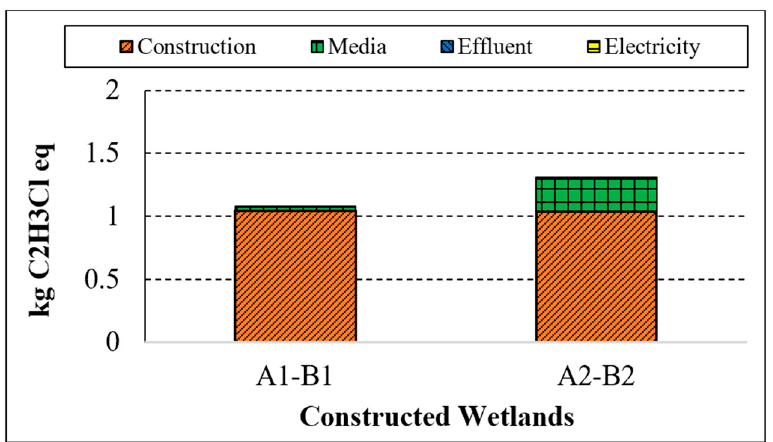
Figure 7. Impact assessment from carcinogens for two different CW systems.